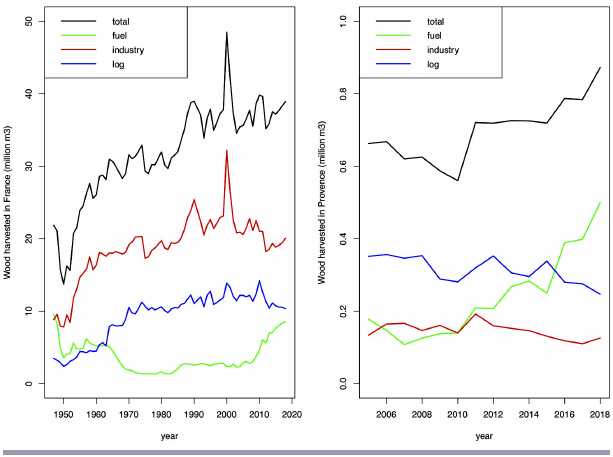
Fig. 1 . Temporal evolution of wood harvested (total, for fuel, for industry, and for log purposes) in France (left) from 1948 to 2015 and in Provence region (PACA), from 2005 to 2015 (right) in Million m3 obtained from the Ministerial Statistical Service of Agriculture